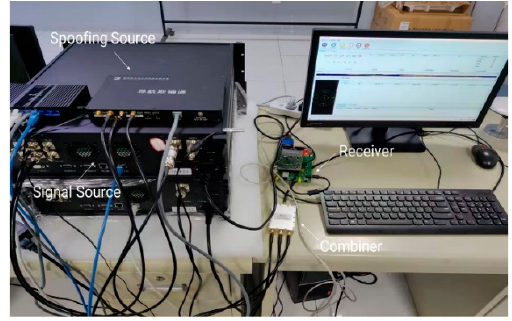
Figure 10. Simulation environment.